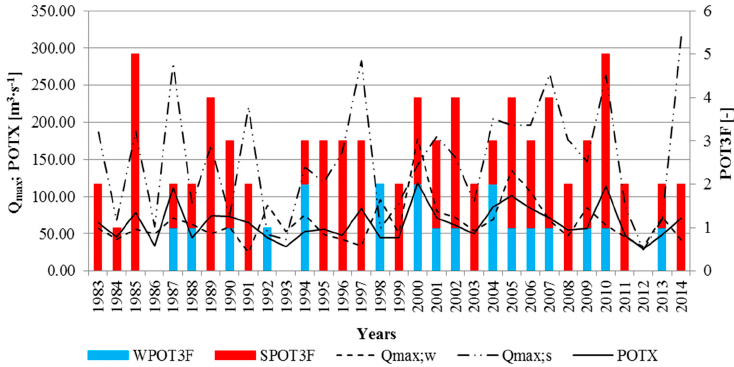
Figure 2. Q max;s , Q max;s , POTX, WPOT3F, SPOT3F and POT3F metrics for the catchment of the